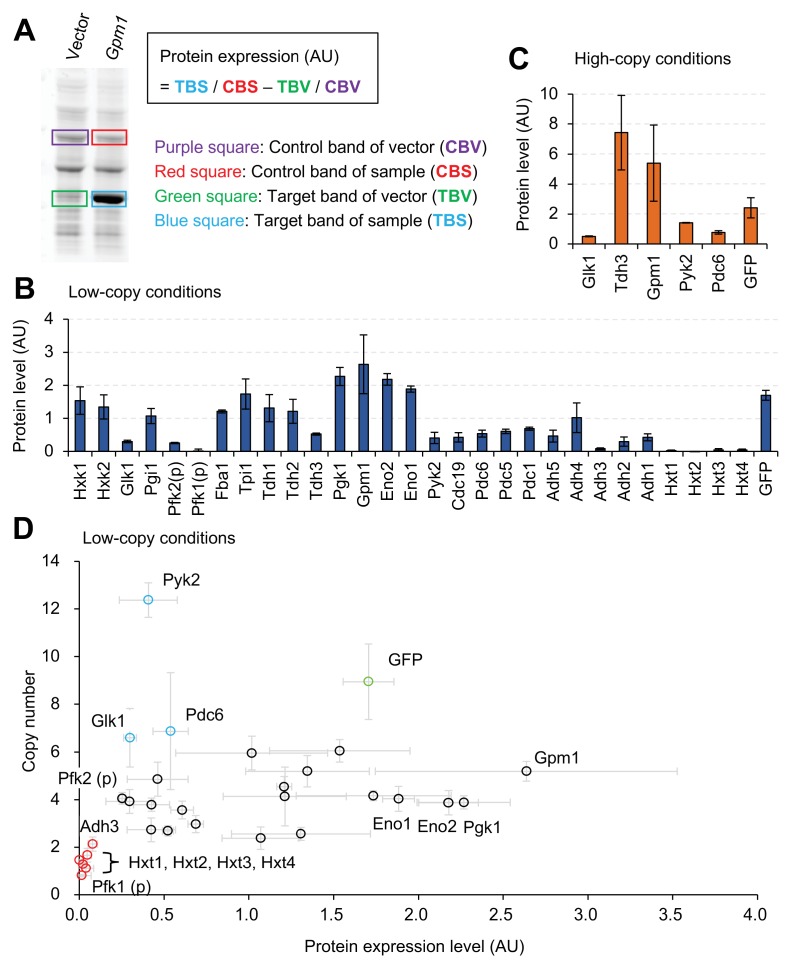
Expression limits of glycolytic proteins.(A) Measurement of the expression level of an overexpressed glycolytic protein. Whole cellular proteins were stained by a fluorescent dye and separated by SDS-PAGE. The overexpression of the target protein (TBS), estimated from the intensity of it's band on the gel an its molecular weight, was compared with the corresponding expression of the vector control (TBV), after normalization using control bands (CBS and CBV) to calculate protein expression (AU). Measurement of Gpm1 expression level is shown as an example. (B and C) The expression level of glycolytic proteins overexpressed using the experimental system shown in Figure 1 in the indicated conditions. The TDH3 promoter was used for the expression of all genes except where (p) indicates the use of the PYK1 promoter. (D) Relationship between copy number and protein level in low-copy conditions. The copy number data are the same as in Figure 1D, and the protein level data are the same as in Figure 2B. The error bars shows the standard deviation of at least three independent biological measurements.10.7554/eLife.34595.009Figure 2—source data 1.This spreadsheet contains all data and statistical values associated with the figure.